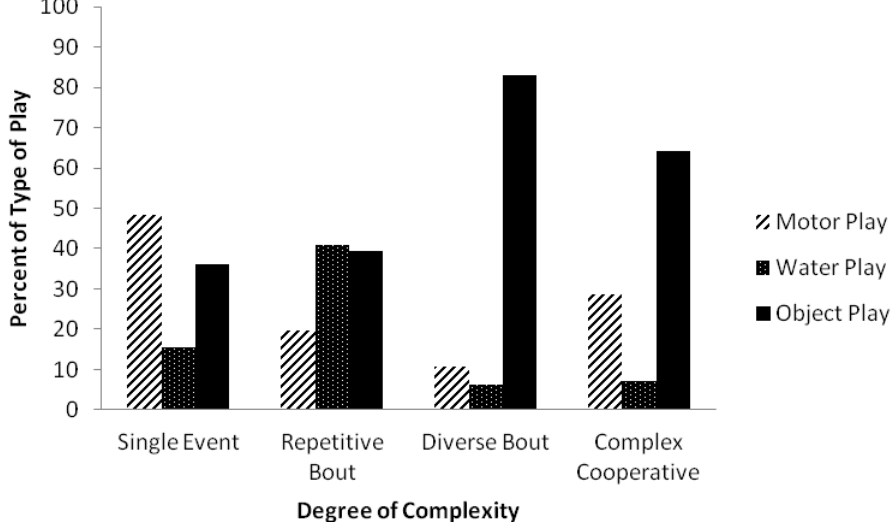
Figure 3. Percent of type of play per complexity of play